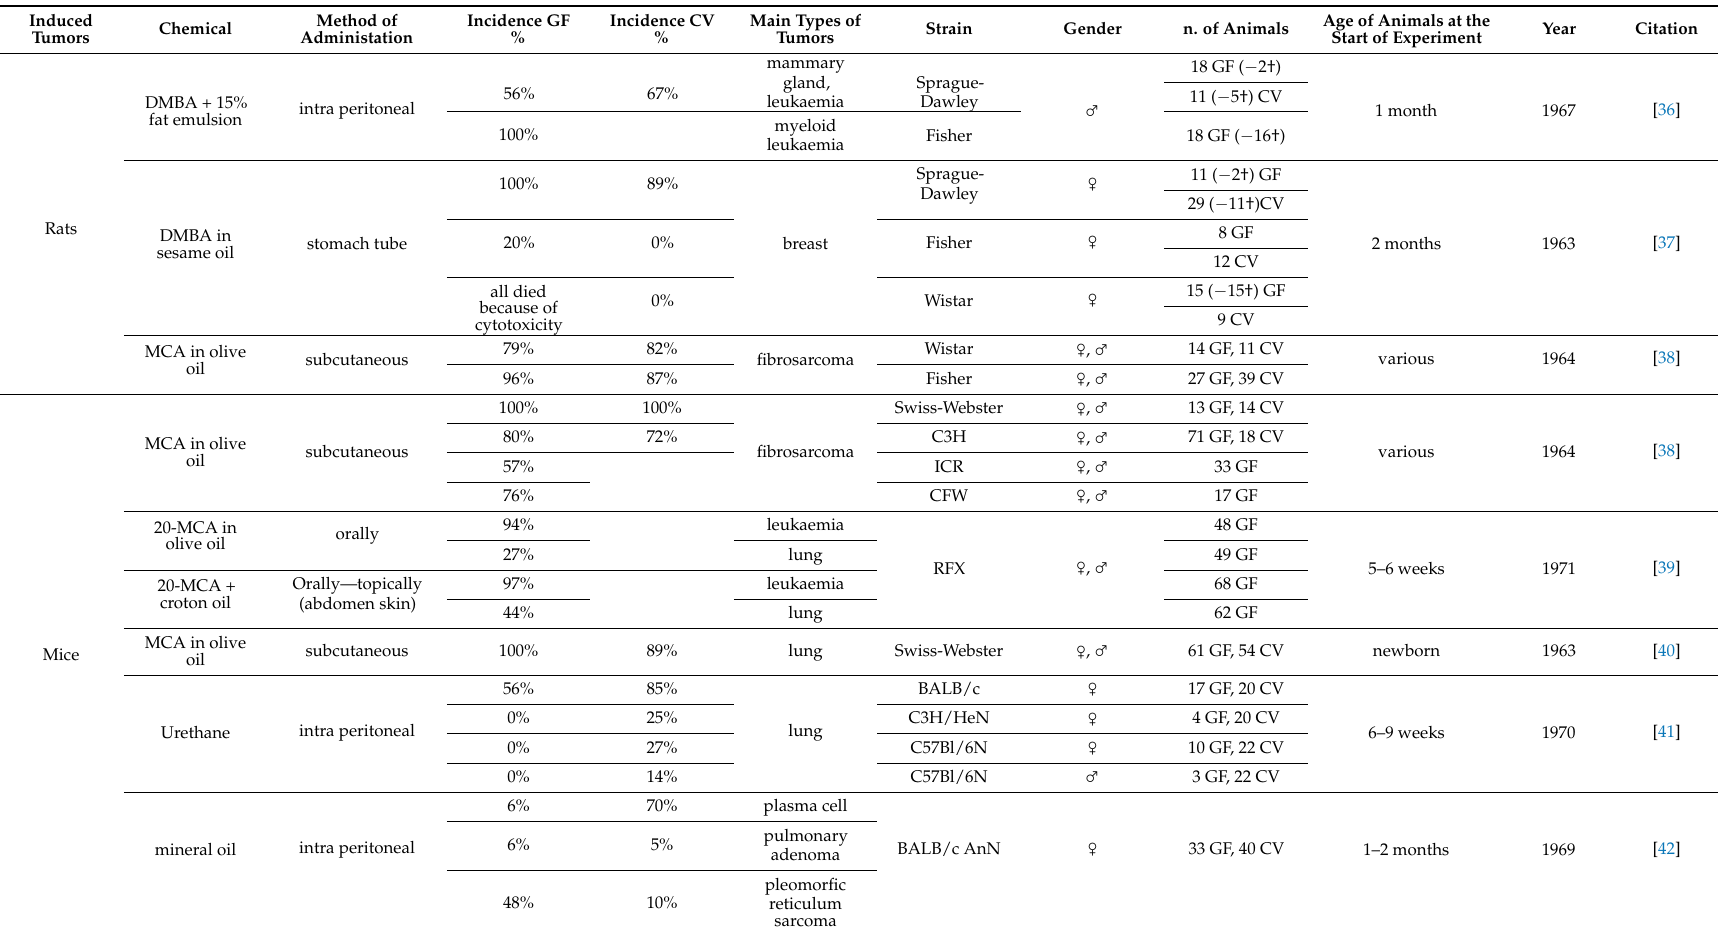
Table 3. Tumor occurrence in GF rats and mice induced with chemical